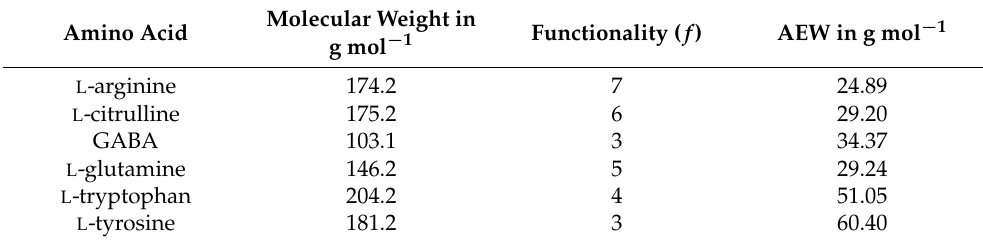
Table 1. Molecular weight, assumed number of active hydrogen atoms ( f ), and resulting amine equivalent weight (AEW) of the amino acids used as curing